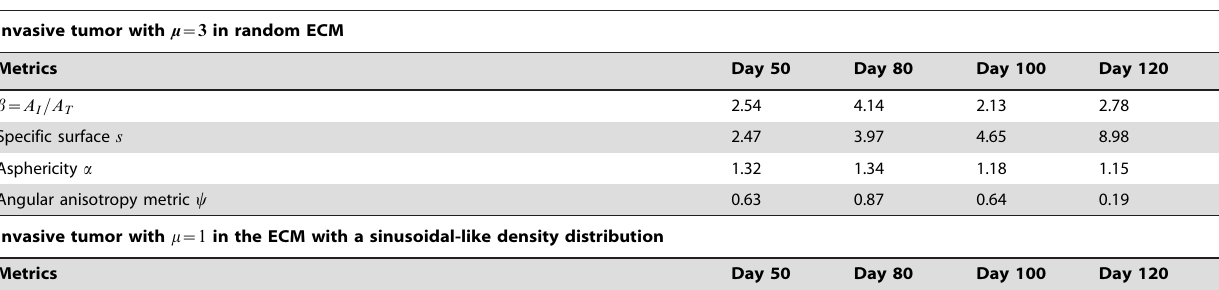
Invasive tumor with m ~ 3 in random ECM